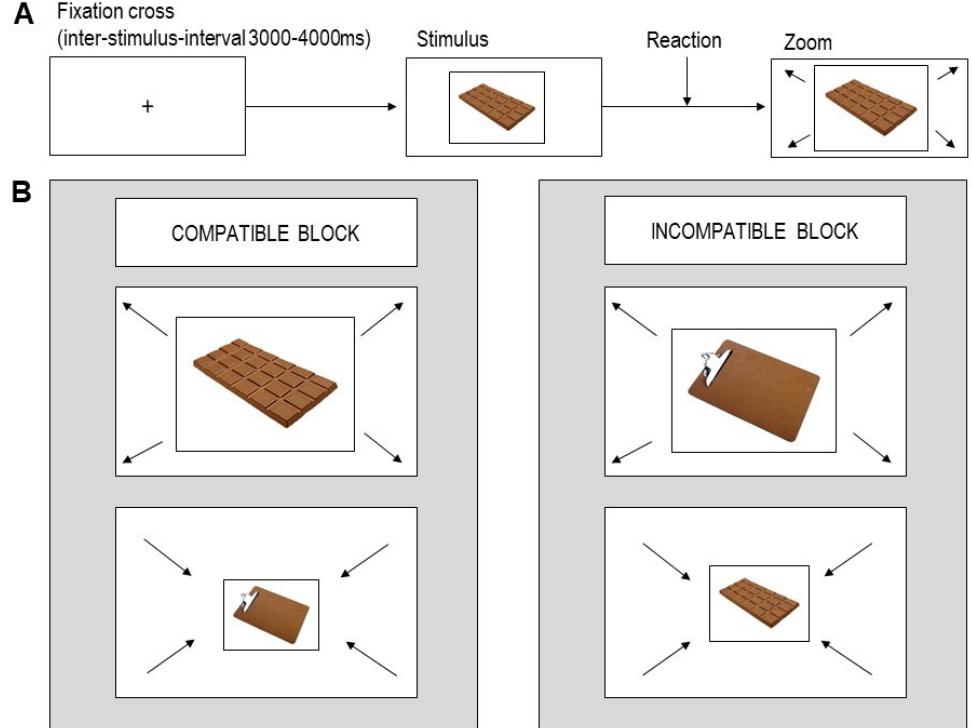
Figure 1. ( A ) Timeline of a single trial. ( B ) Task setup: relevant feature approach–avoidance task .